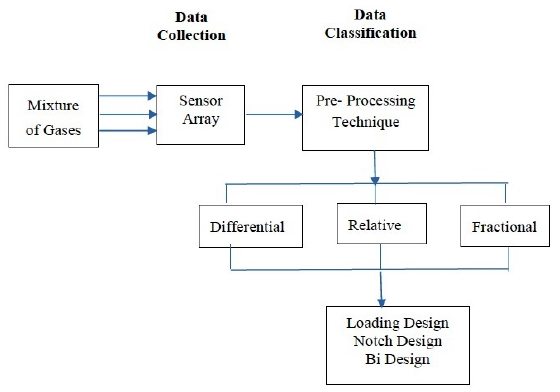
Figure 1. Block diagram of gases—data collection and classification.